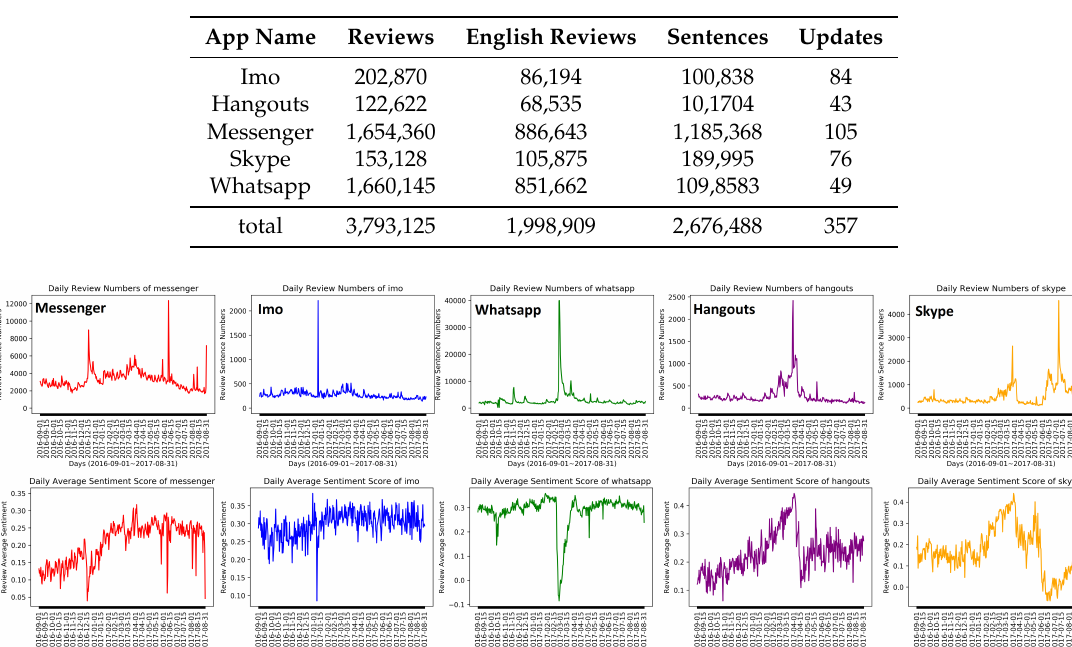
Table 2. Application (app) review statistics.